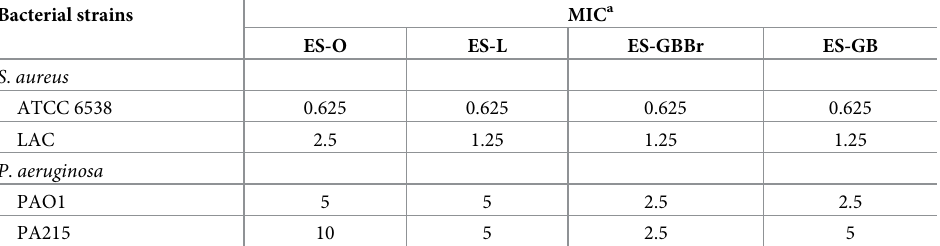
Table 2. Susceptibility of bacterial strains to crude Bald’s eyesalve formulations. Bacterial